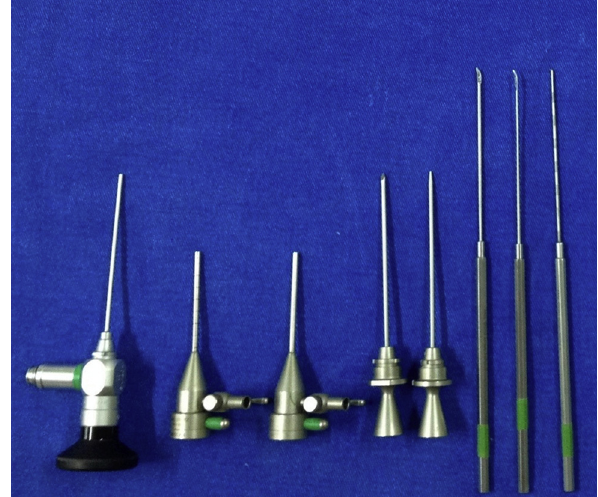
Instrumentation with angled probe to remove ante- rior recess